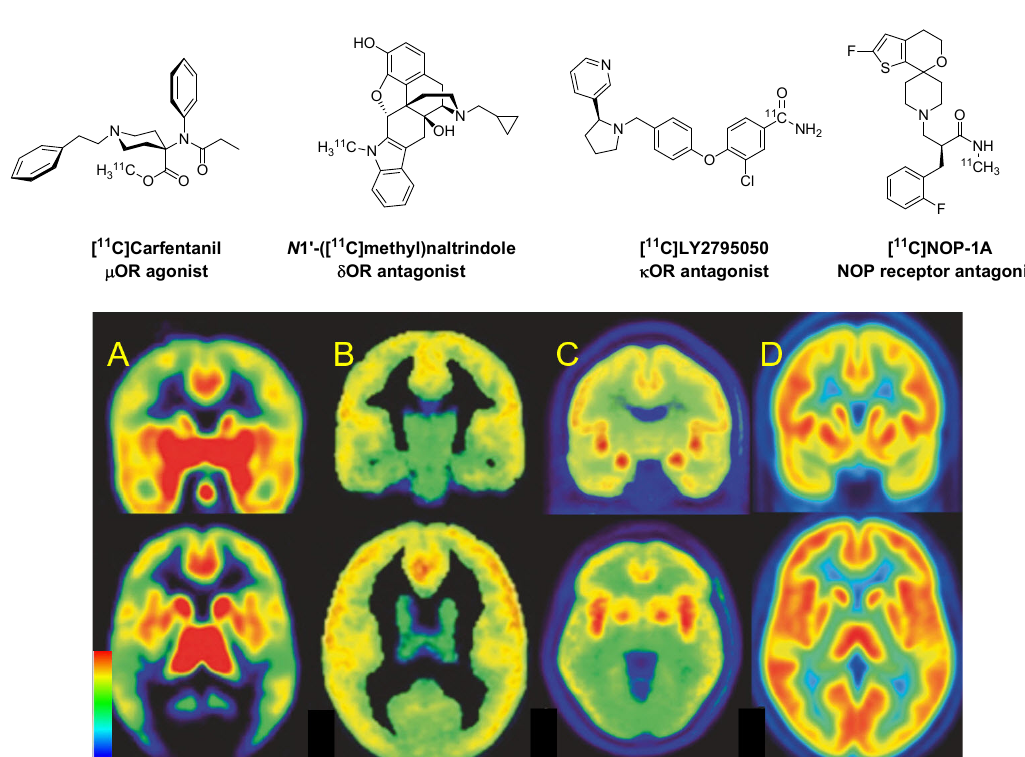
Figure 2. Human brain opioid receptor PET images in coronal (upper row) and axial (lower row) planes. Modified and reproduced with permission from Peciña et al. [19]. From left to right, we see ( A ) the μOR agonist [ 11 C]carfentanil, binding most abundantly in the caudate nucleus, anterior cingulate cortex, thalamus, and pituitary gland; ( B ) the δOR antagonist N 1′-([ 11 C]methyl)natrindole, which has diffuse binding throughout neocortex; ( C ) the κOR antagonist [ 11 C]LY2795050, which has high binding in the insular cortex, lateral frontal cortex and amygdala; ( D ) the NOP antagonist [ 11 C]NOP-1A, which binds abundantly throughout the brain. Binding sites of μ-, κ- and NOP-OR ligands are expressed as binding potential relative to the cerebellum (BP ND ), whereas binding of the δ-ligand (which has no non-binding reference region) is expressed as net influx ( K i ,) in units of perfusion (mL cm −3 min −1 ). The color scale in the lower right indicates (for A , C , and D ) BP ND ranging from 0 to 2, or ( B ) K i ranging from 0–0.1 mL cm −3 min −1